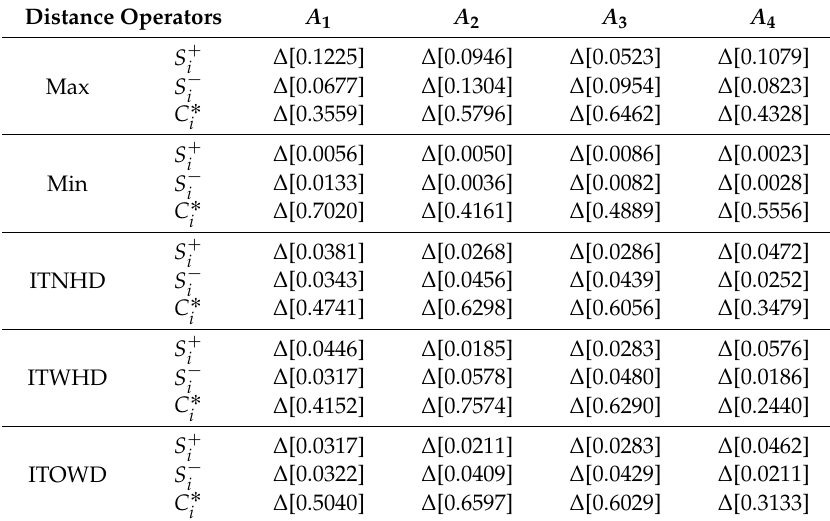
Table 6. Aggregated results 1.